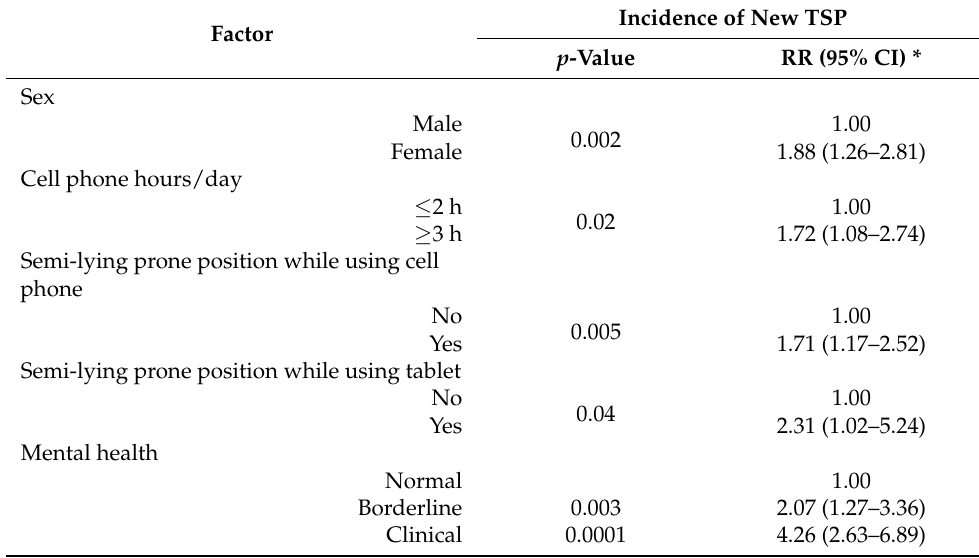
Table 4. Multivariate logistic regression comparing no TSP during either T1 or T2 (score = 0) with TSP only at T2 (score =